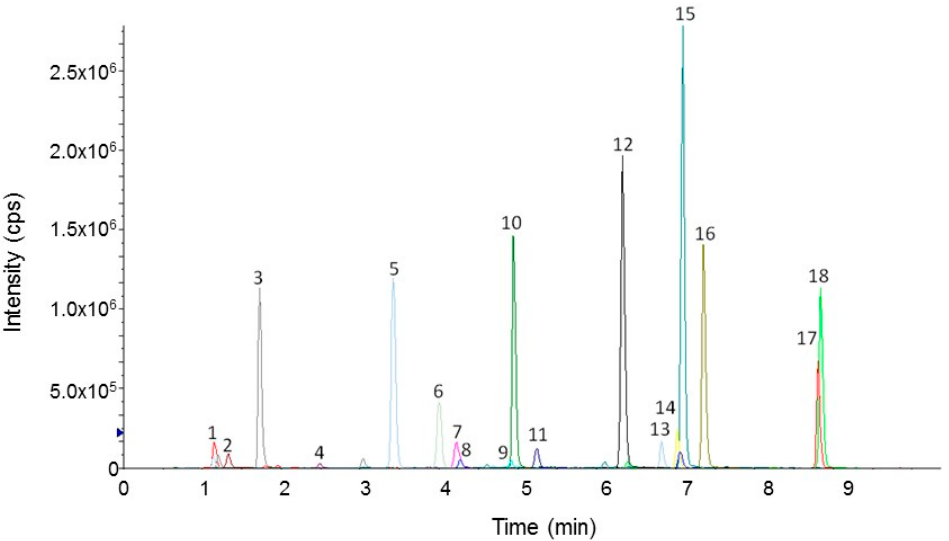
Figure 2. XIC of the peptide mixture obtained by the simulated digestion of 50 mg of Spirulina powder A.